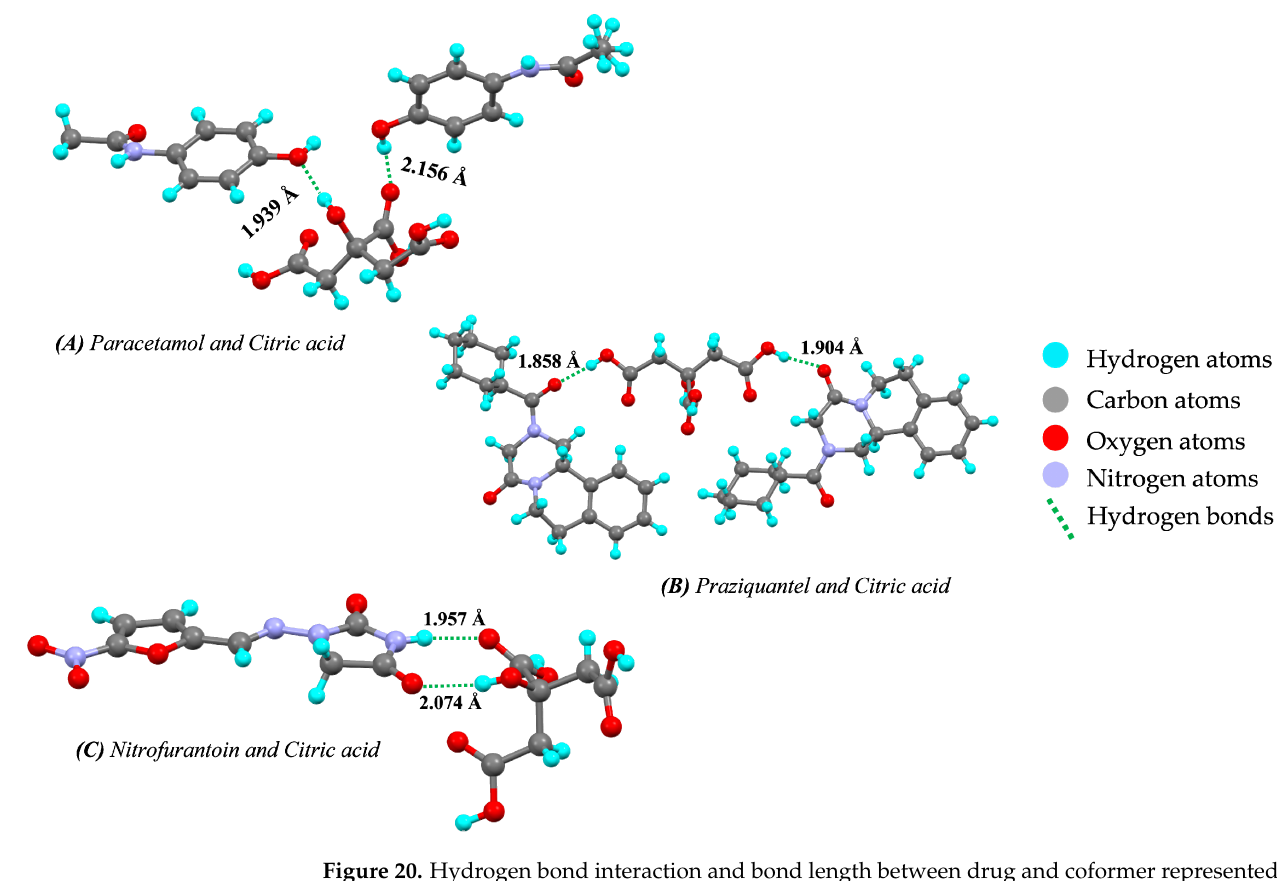
Figure 20. Hydrogen bond interaction and bond length between drug and coformer represented as ( A ) Paracetamol and citric acid (#803736), ( B ) Praziquantel and citric acid (#2094551), and ( C ) Nitrofurantoin and citric acid (#835423) (from Mercury 2022.2.0 (Build 353591)). #—CCDC Identifier number. Table 11. Impact of citric acid as a coformer on